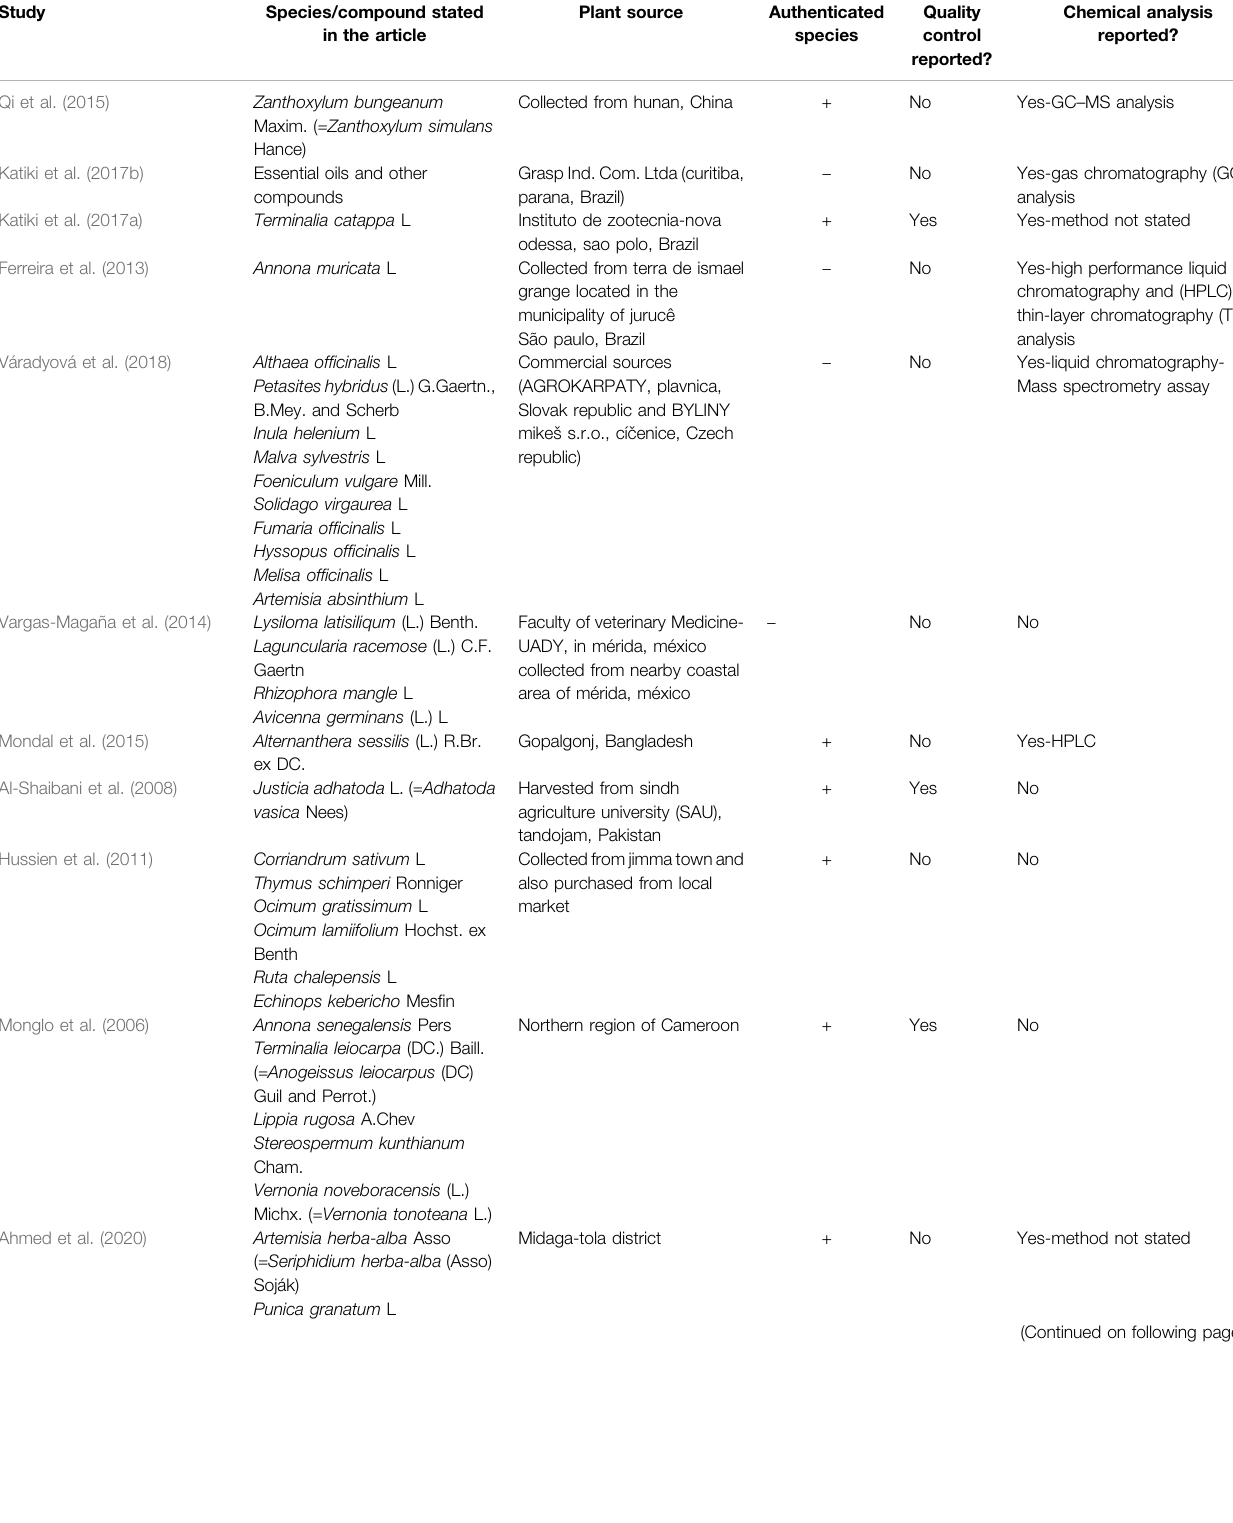
TABLE 1 | ( Continued ) Quality assessment of the articles selected for this systematic